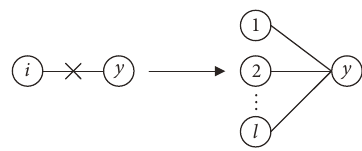
Figure 3: Decomposition of the neuron in the hidden